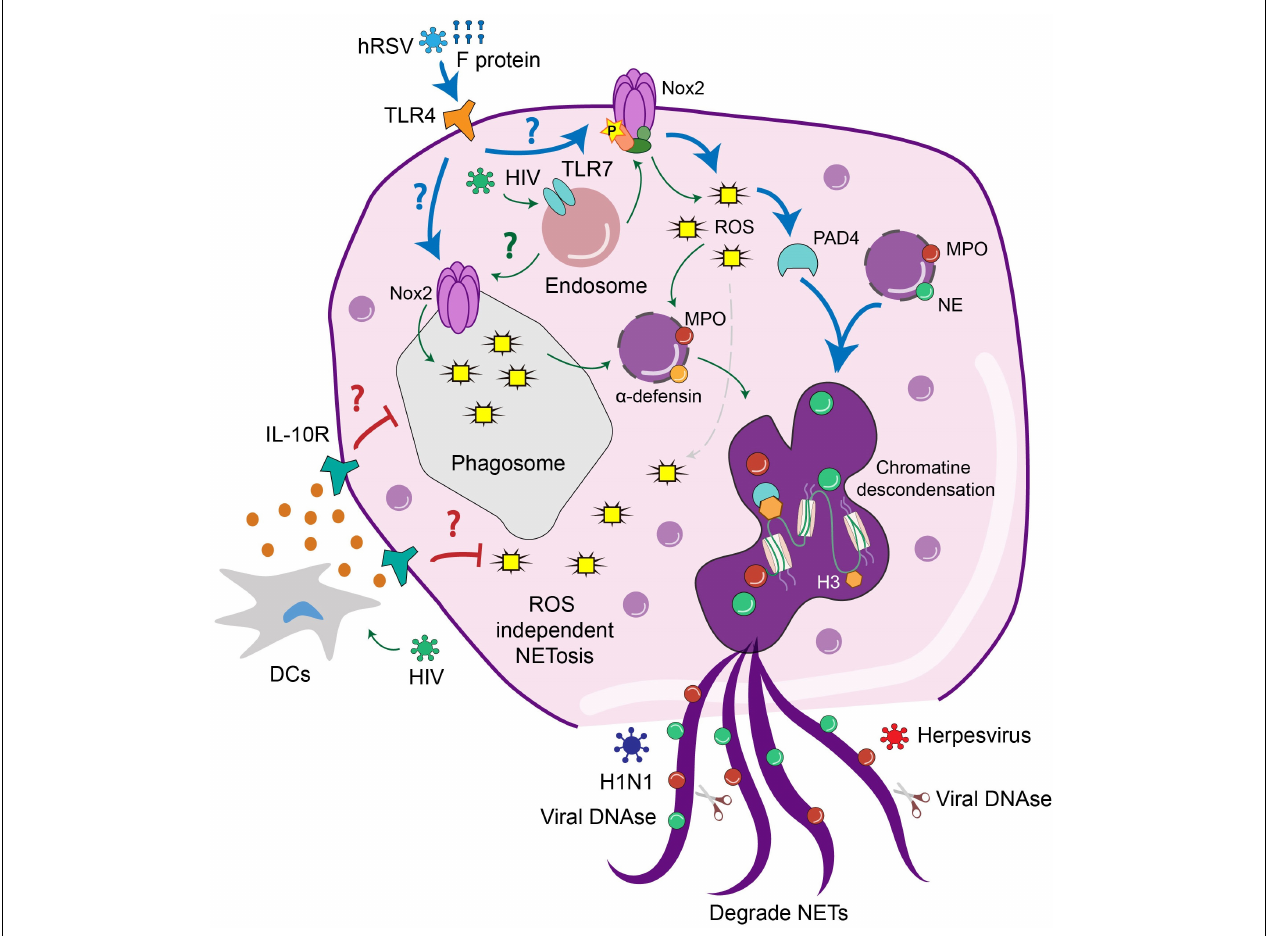
FIGURE 2 | The release and activity of NETs is modulated by viral infection. Interaction of neutrophils with different viruses activates extracellular or intracellular pathways that lead to the NET formation. HIV triggers TLR7 signaling in the endosomes of neutrophils leading to the production of ROS and subsequently NETs release. HIV infection of DCs triggers the production of IL-10, which suppresses the formation of NETs and may allow pathogen spreading. HRSV infection triggers TLR4 signaling at the cell surface, which results in ROS-dependent NETs release. In the case of H1N1, this virus triggers ROS independent NETs release which may prevent pathogen spreading. In contrast, the activity of DNases from Herpesviruses can degrade NETs to allow viral dissemination.